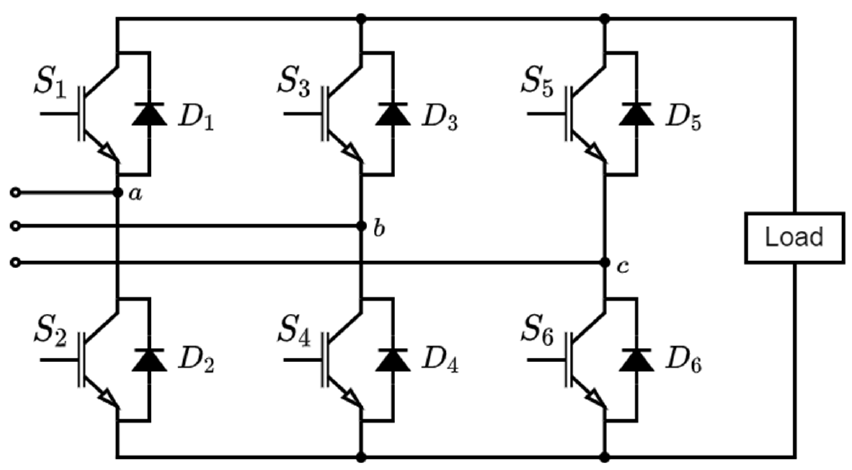
Figure 12. Three-phase rectifier with active switches (IGBTs).